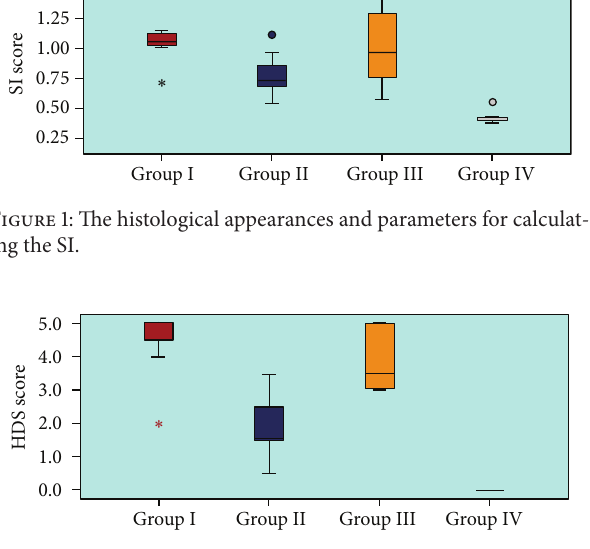
Figure 2: The histological appearances and parameters for calculat- ing the